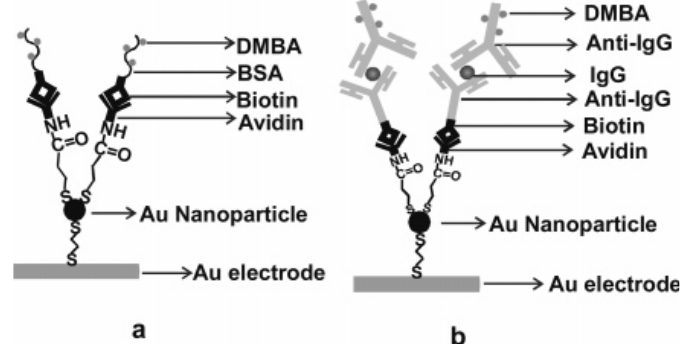
Figure 1. Schematic diagrams of immobilization of BSA (a) and IgG (b) on the gold electrode with gold nanoparticle amplification. Reprinted from Ref [20] with permission from The American Chemical